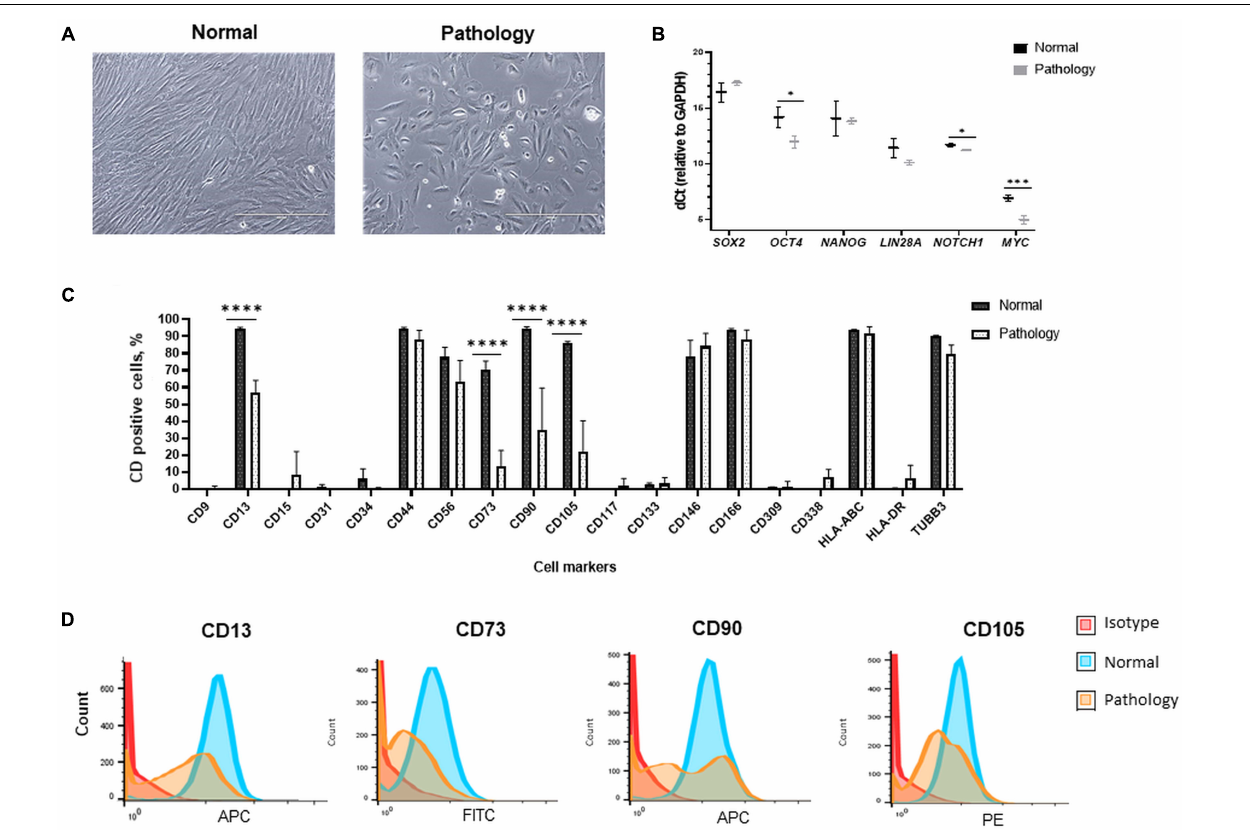
FIGURE 1 | Morphological, gene expression, and cell surface marker characterization of hAFSCs derived from normal and fetus-affected gestations. (A) Morphology of hAFSCs cells from a healthy donor (Normal) and pathological gestation (Pathology [Pat1]) amniotic fluid samples (representative images; scale bar = 400 µ m). (B) RT-qPCR analysis of pluripotency gene markers in samples of hAFSCs of normal (Normal, n = 3) and fetus-pathological (Pathology, n = 3) gestations. mRNA expression levels were normalized to GAPDH and presented as mean values of (cid:49) Ct ± SD. *Denotes significant difference with p < 0.05 and ***denotes significant difference with p < 0.005, as evaluated using two sample t -test. (C) Cell surface marker expression of CD9, CD13, CD15, CD31, CD34, CD44, CD56, CD73, CD90, CD105, CD117, CD133, CD146, CD166, CD309, CD338, HLA-ABC, and HLA-DR and cell expression of TUBB3 determined in hAFSCs from healthy